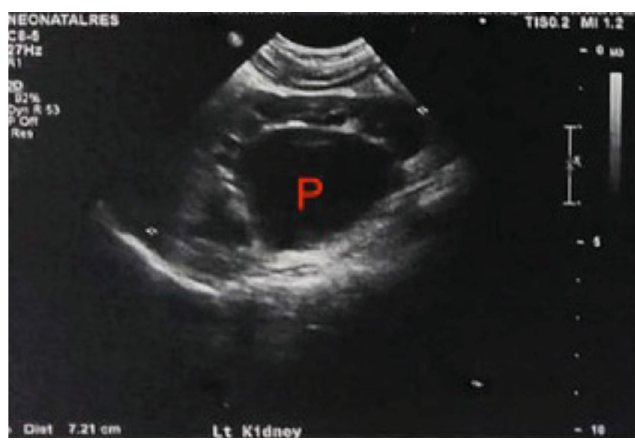
Figure 1: Ultrasound showing severe left PUJO at presentation.